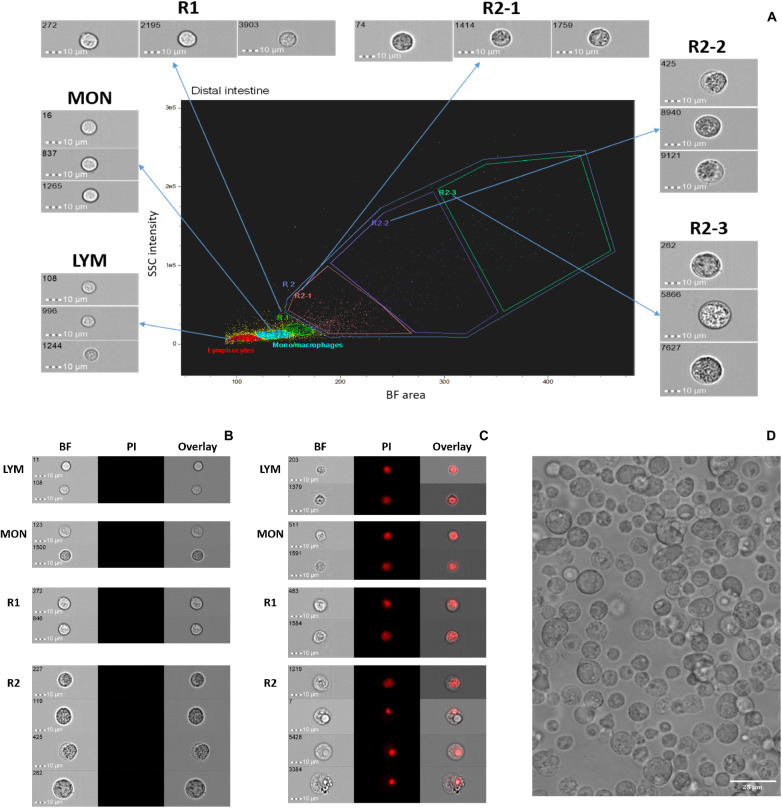
Cell populations from Atlantic salmon distal intestine. (A) Live cells are shown in a brightfield (BF) area (cell size) vs. side scatter (SSC) intensity plot (cell granularity). Representative images (40 × objective, scale bar = 10 μm) from each gate are shown separately. Intestinal cells were identified based on nucleus morphologies. Using propidium iodide, live or no-stained cells (B) and dead or nucleus-stained cells (C) are shown. (D) A representative image captured by fluorescent imager (20 × objective, scale bar = 25 μm) shows salmon intestinal cell population. LYM, lymphocytes; MON, monocytes/macrophages; R, region: R1, macrophage-like cells; R2, unknown cells; R2-1, R2-2, presumptive granulocytes; R2-3, presumptive vacuolated cells.